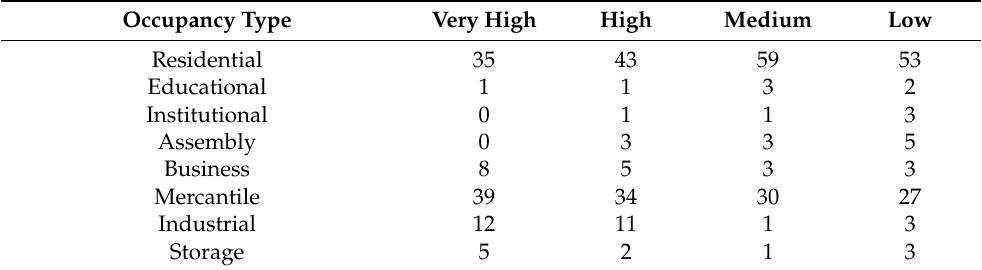
Table 5. Percentage of fires based on occupancy types in classified fire risk zones.